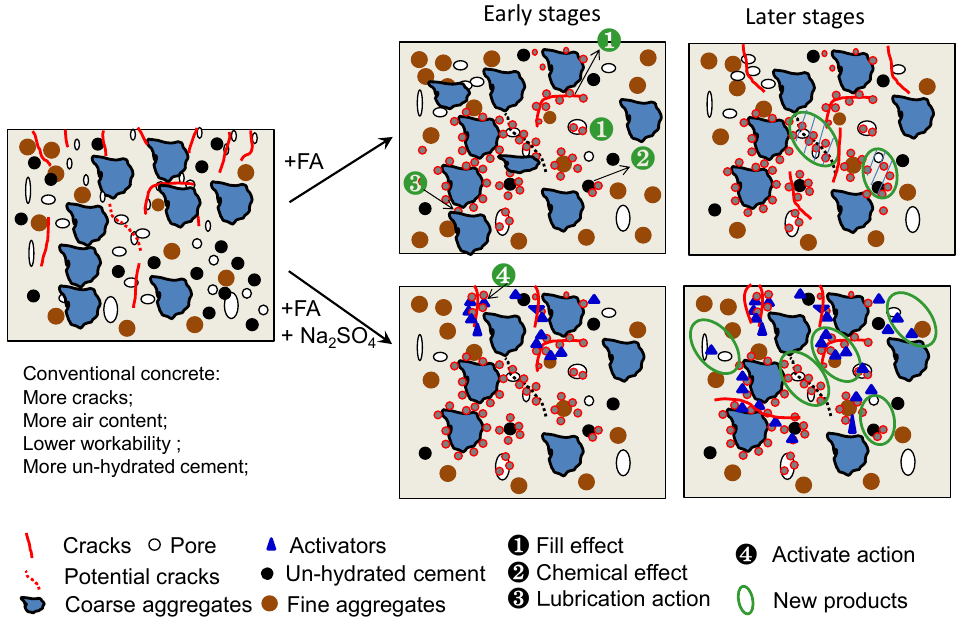
Figure 15. Mechanism of the crack ‐ resistance of FAC activated by Na 2 SO 4 .